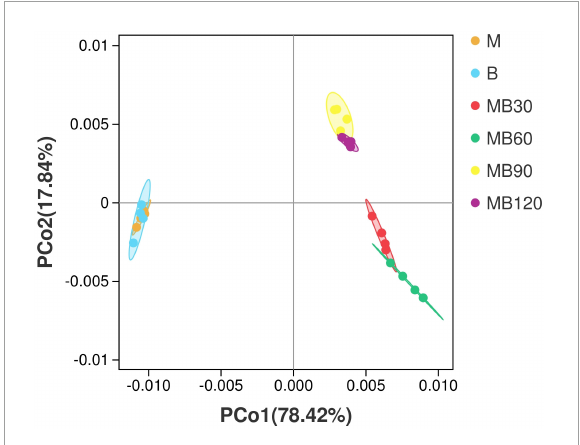
FIGURE1 Principal coordinates analysis (PCoA) of bacterial communities for fresh materials and silage. M, maize; B, faba bean; MB30, 30 days of mixed silage of maize and faba bean; MB60, 60 days of mixed silage of maize and faba bean; MB90, 90 days of mixed silage of maize and faba bean; MB120, 120 days of mixed silage of maize and faba